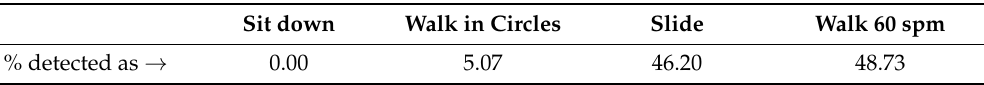
Table 5. Percentage of false positives.